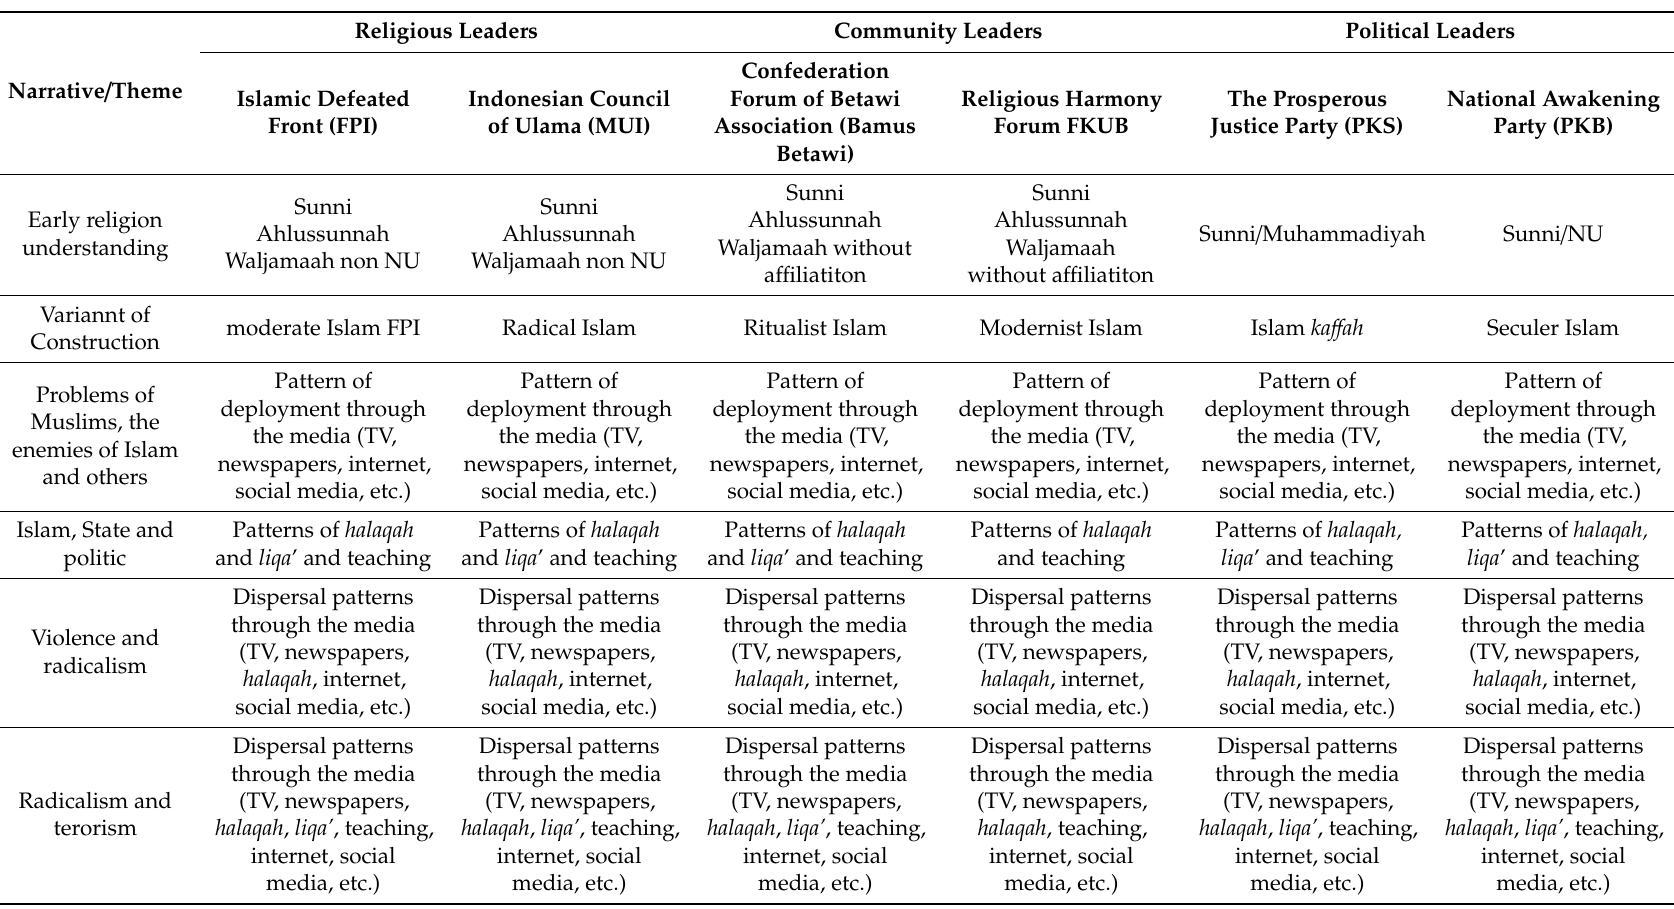
Table 1. Patterns of Radicalism and Terrorism Narrative Deployment in Jakarta Metropolitant: Religious Leaders, Community Leaders and Political Leaders.